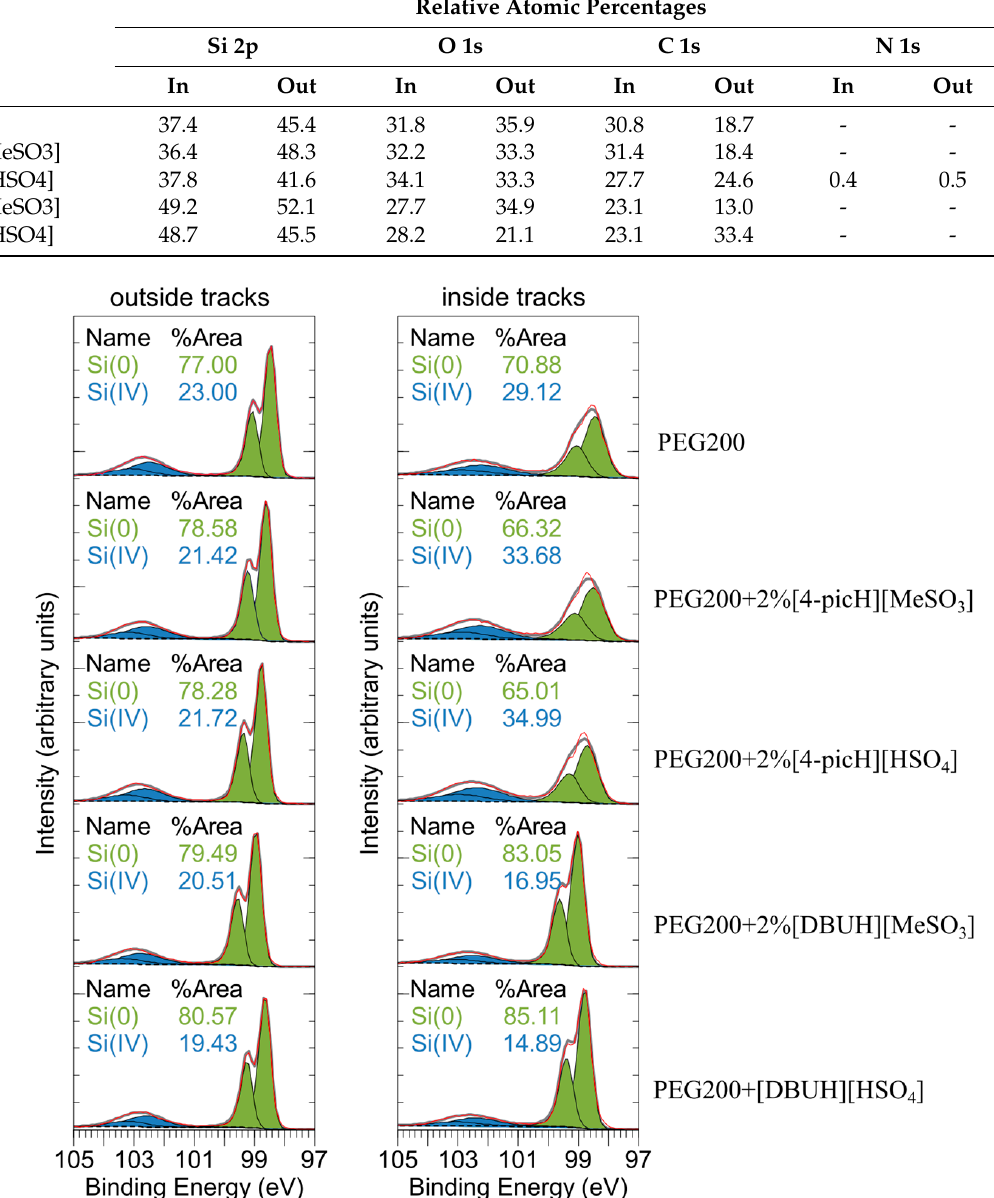
Figure 8. XPS Si 2p emission from outside ( left ) and inside ( right ) of the wear tracks (shown in Figure 6). Red: original data, dashed black line: background, green: Si 0 components, blue: Si 4+ components, grey: envelope. Each silicon oxidation state is fitted with two components of the same color, corresponding to the Si 2p 3/2 and Si 2p 1/2 doublets, separated by 0.6 eV and with identical line width, respectively.